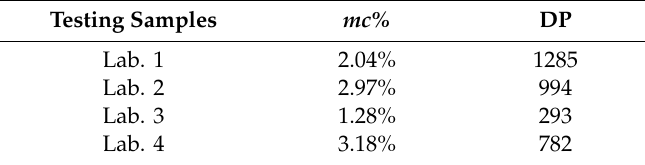
Table 6. Insulating information of the lab